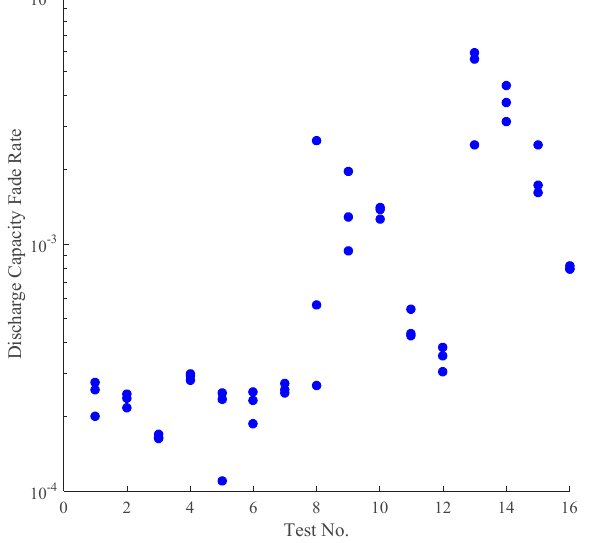
Figure 7. Capacity fade rate (Y) for batteries from Manufacturer 2 for Tests 1–16.